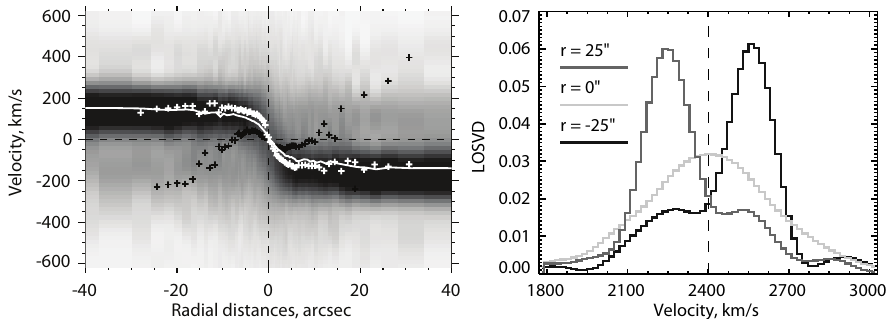
Fig. 2. Left panel. The position vs. velocity diagram. White line presents a radial velocity profile obtained using one-component model. Black and white crosses correspond to the ‘bulge’ and ‘disk’ components in the two-component model. Right panel. The LOSVD at the radii –25, 0 and 25